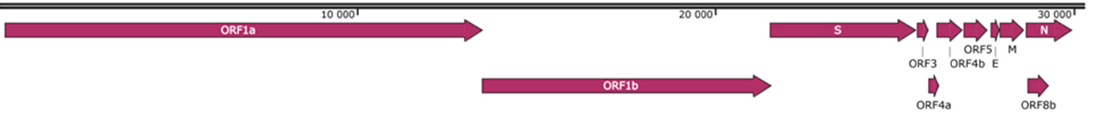
Figure 2. Genomic organization of MOW-BatCoV, strain 15-22. Illustrated reading frames (ORFs) have the following order and encode the listed genes: ORF1ab (putative mature nonstructural proteins, including RNA-dependent RNA polymerase (RdRp); S (Spike); ORF3 (hypothetical NS3); ORF4a (hypothetical NS4a); ORF4b (hypothetical NS4b); ORF5 (hypothetical NS5); E (envelope); M (membrane glycoprotein); N (nucleocapsid phosphoprotein); and ORF8b (hypothetical NS8b).